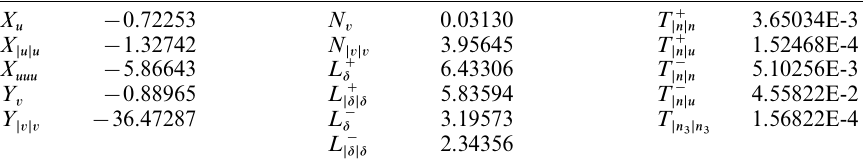
Figure 11. Measured and interpolated bow thrust force T of CyberShip II and di ff erent negative propeller revolutions.